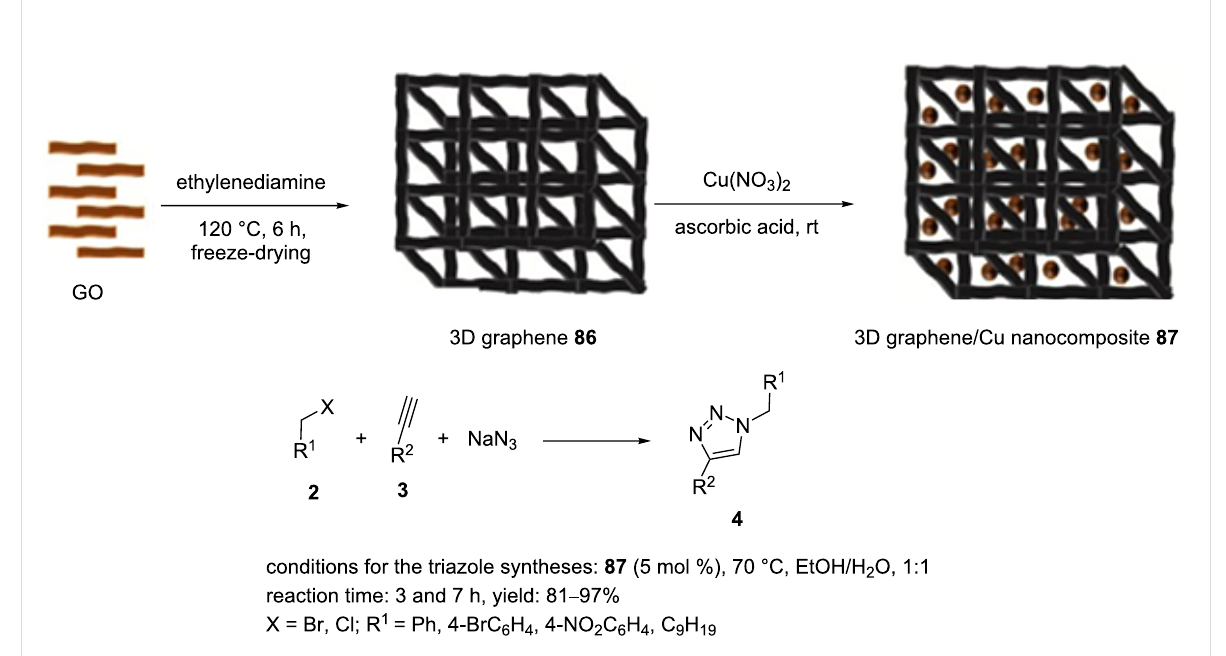
Scheme 18: Synthetic route to the catalyst 87 and catalytic application of 87 in “click”